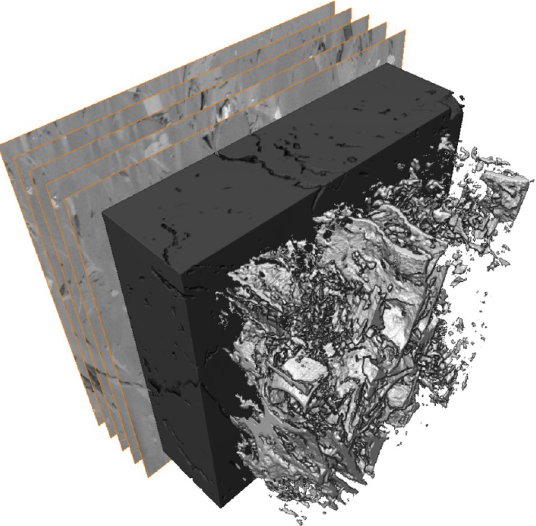
Figure 1. Visualization of the digital rock 3D model reconstructed from processed and segmented FIB-SEM nano-tomography image dataset.